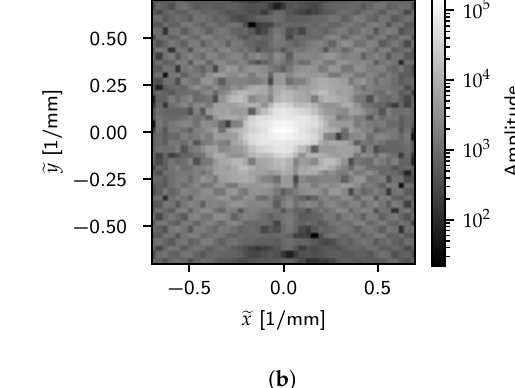
Figure 18. FFT of density for the elliptical case over ( a ) the total frequency domain and ( b ) a low- frequency